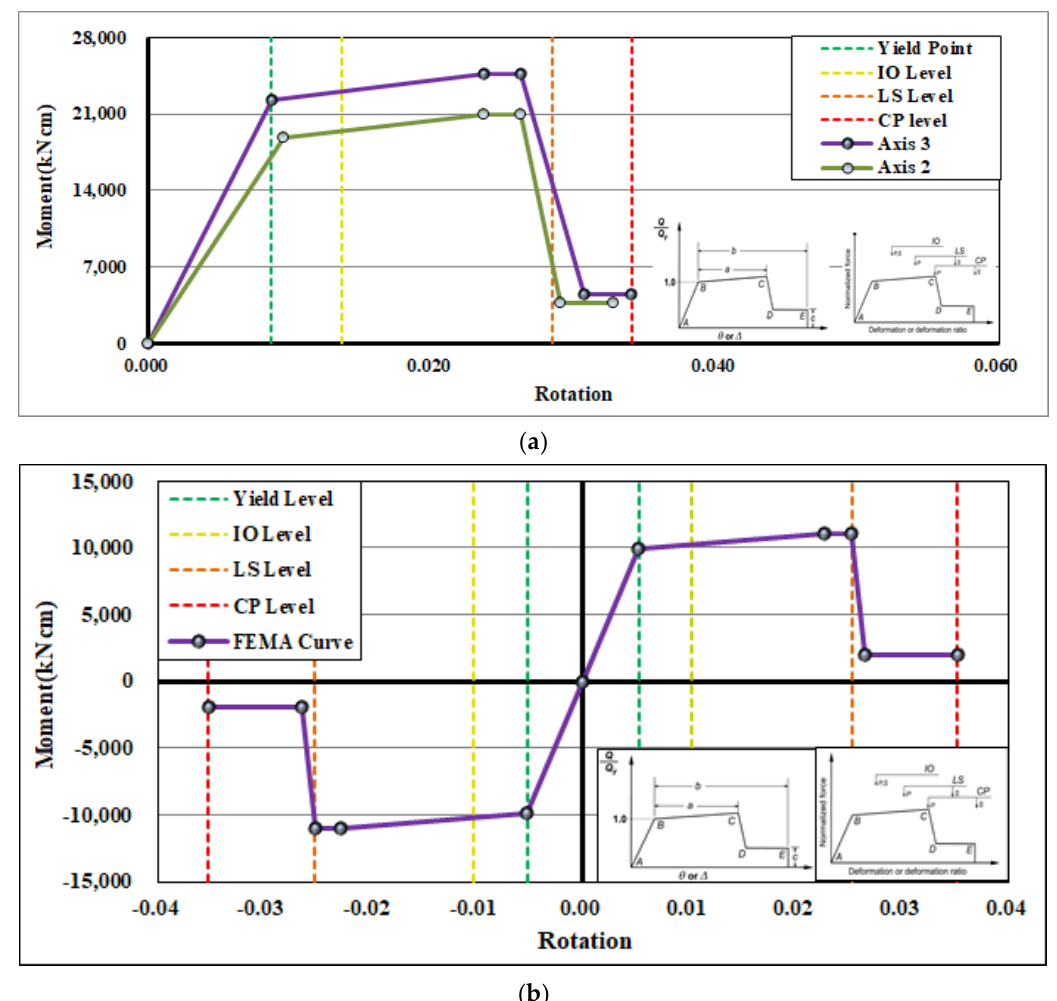
Figure 21. Hinge property of elements. ( a ) Column, ( b ) Girder.